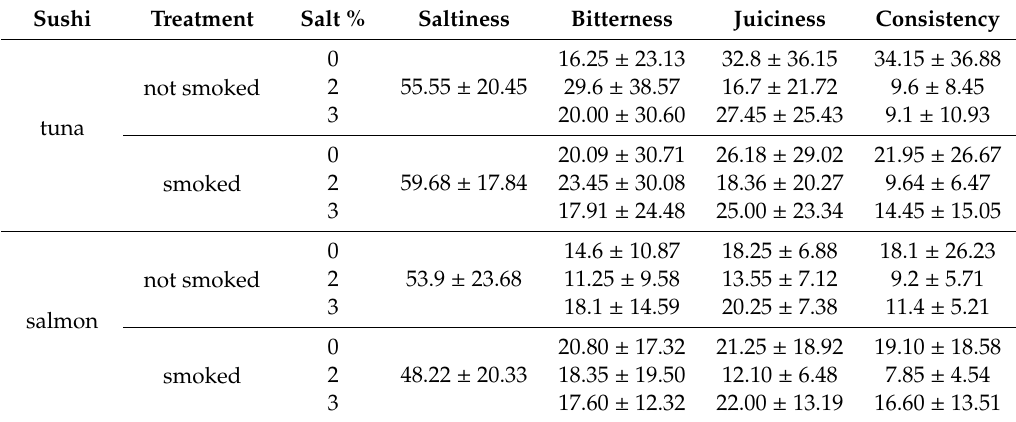
Table 5. Sensory attributes evaluation for nigiri sushi meal with not smoked and smoked samples of tuna and salmon fillets.